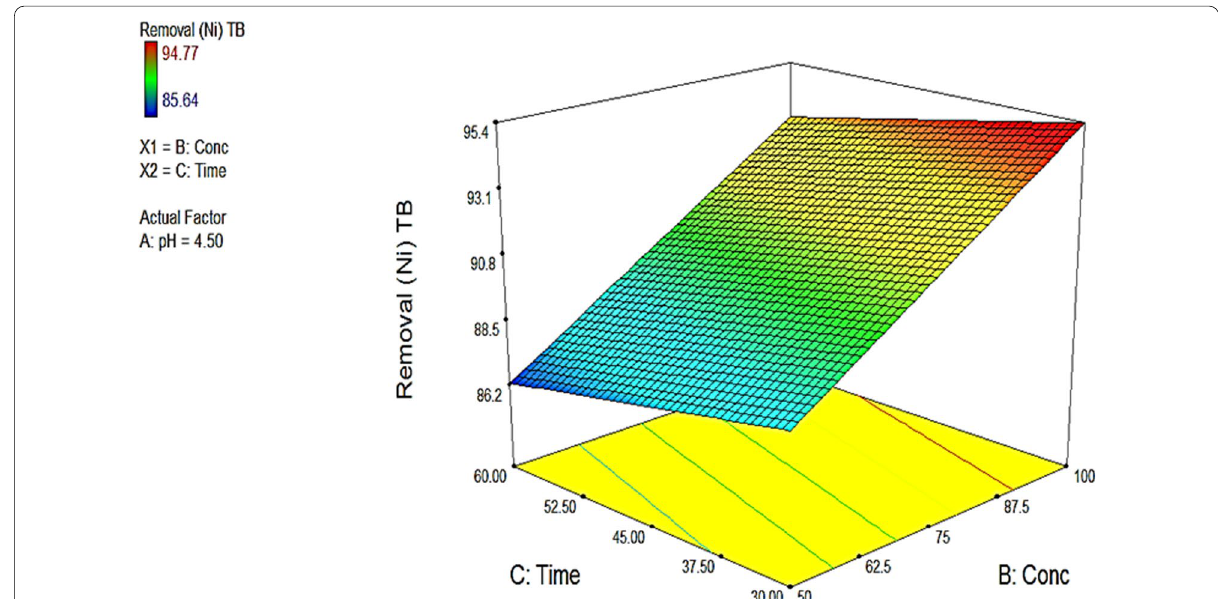
Fig. 10 A 3-dimensional plot of concentration and pH against the percentage removal of Nickel when tea bag residues are used as adsorbent